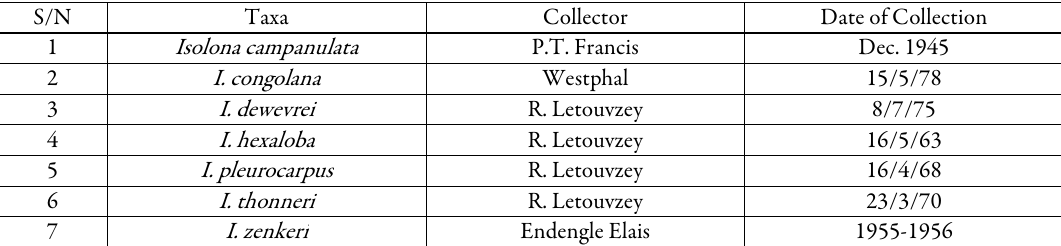
Table 1. List of species used for the study S/N Taxa Collector Date of